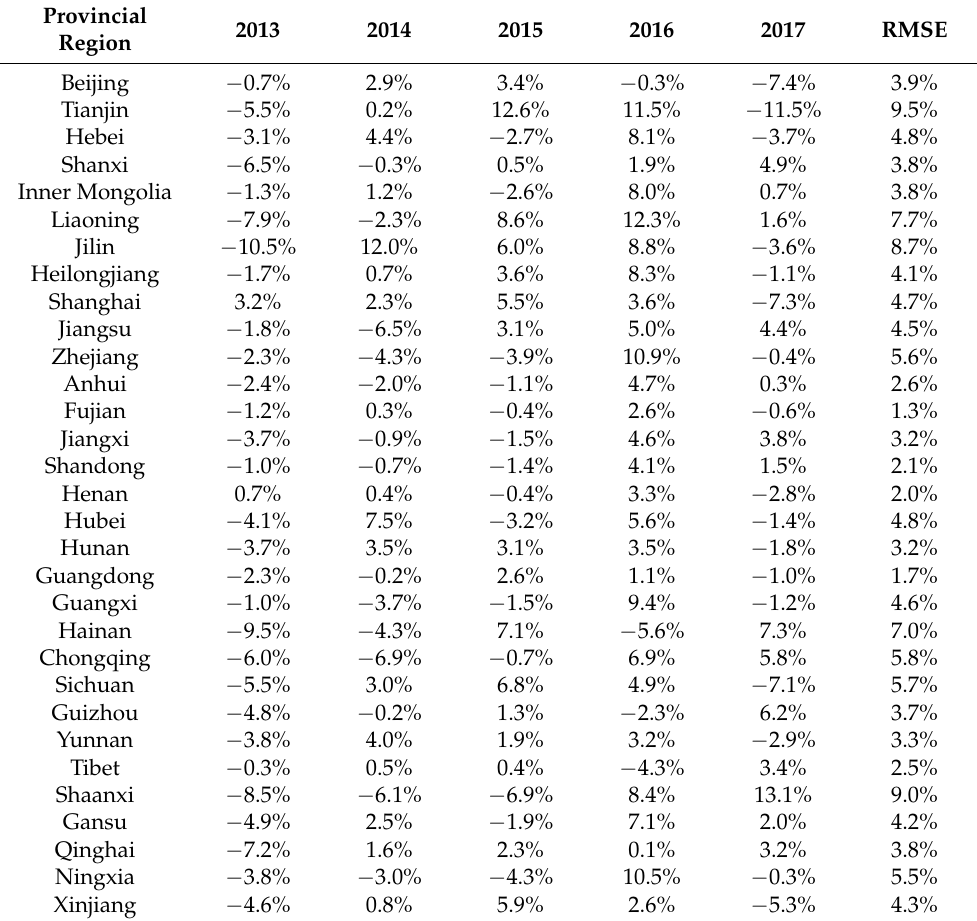
Table 1. Relative errors and root mean square errors (RMSE) for annual total industrial PM 2.5 emissions in mainland China from 2013 to